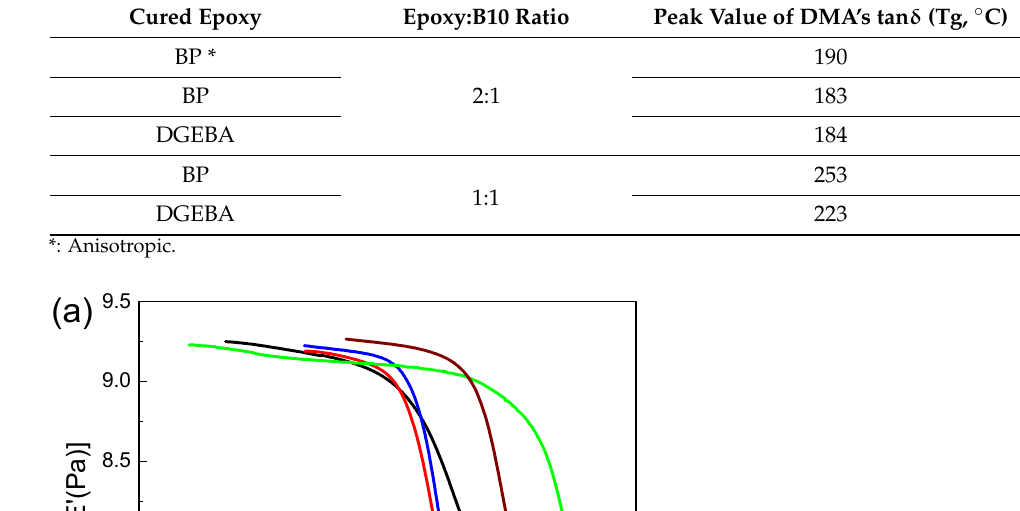
Table 3. Glass transition temperature of cured epoxy resin.